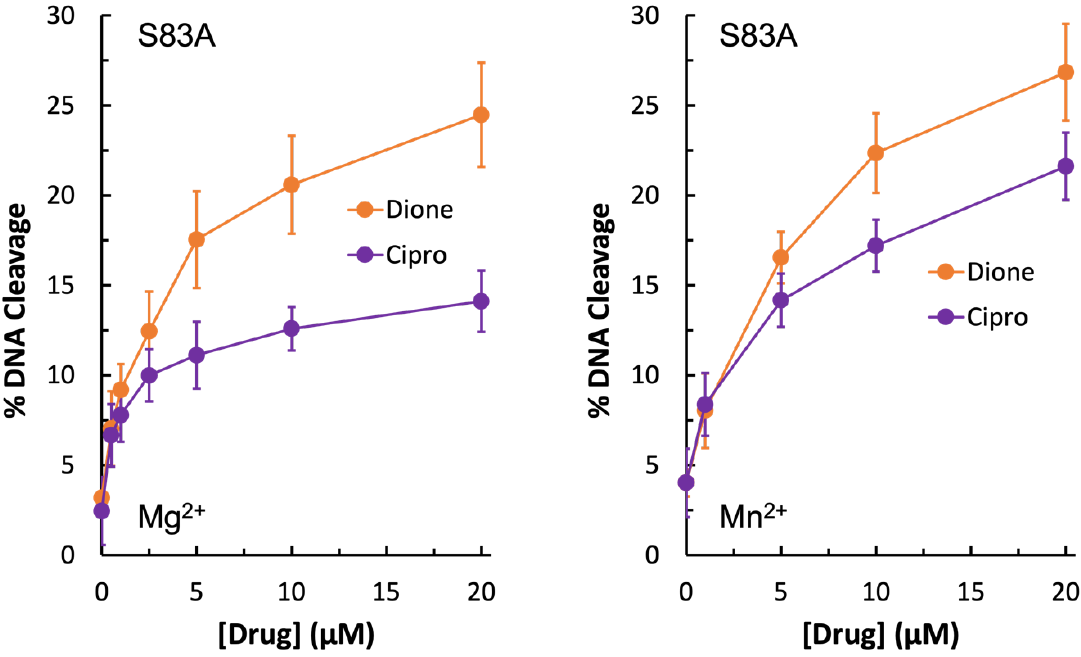
Figure 6. Plasmid DNA cleavage induced by GyrA S83A gyrase in the presence of 0 – 20 µM ciprofloxacin (purple) or quinazolinedione (orange) with 6 mM Mg 2+ ( left ) or 5 mM Mn 2+ ( right ) as the metal ion. Error bars represent the standard deviation of three or more independent experiments.